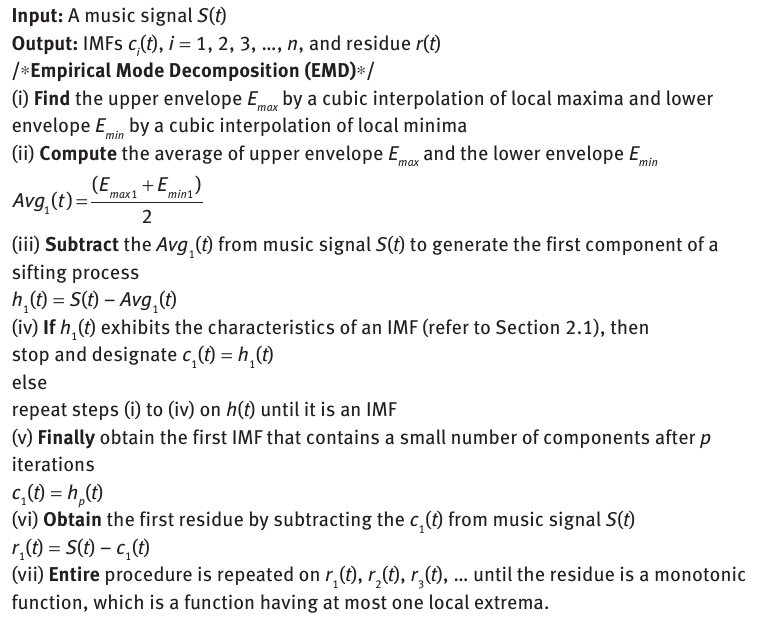
Algorithm 1: Procedure to decompose music signal using EMD